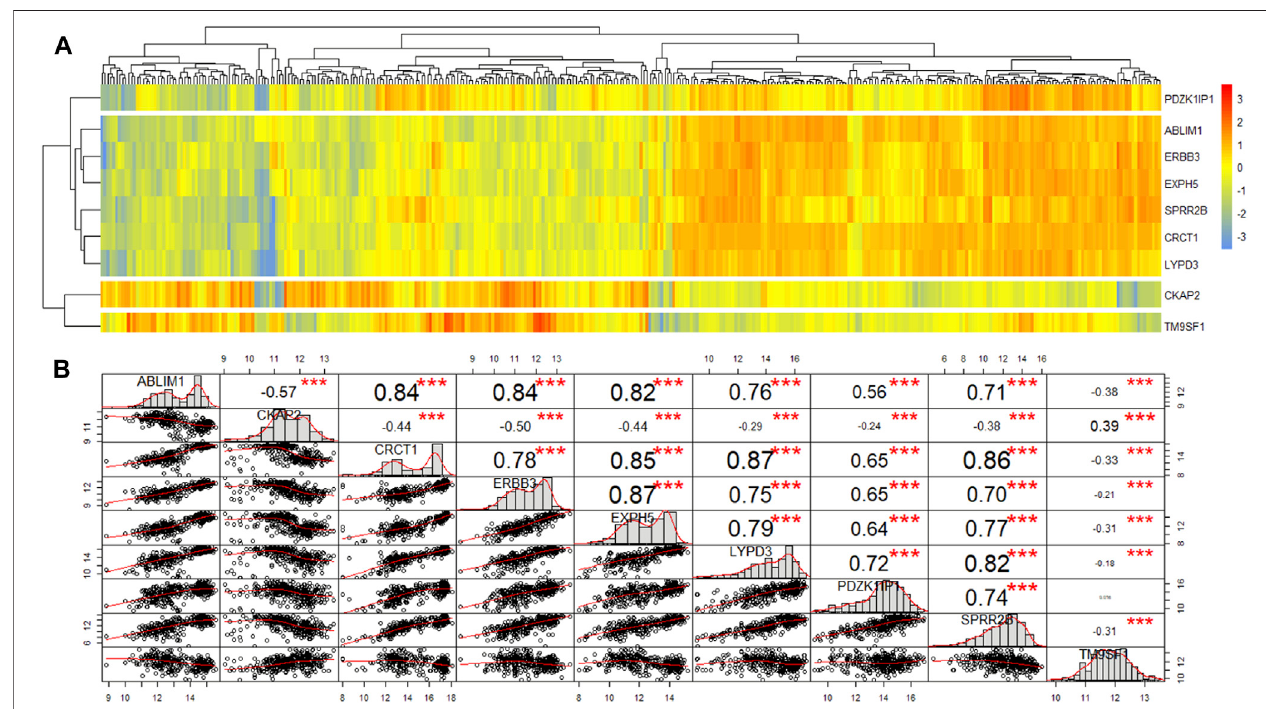
FIGURE 2 | The heatmap and similarity analysis of the expression of nine genes for patients from primary cohort. (A) Heatmap demonstrating unsupervised hierarchical clustering of nine genes for patients from primary cohort. (B) Similarity analysis of the expression of nine genes for patients from primary cohort.